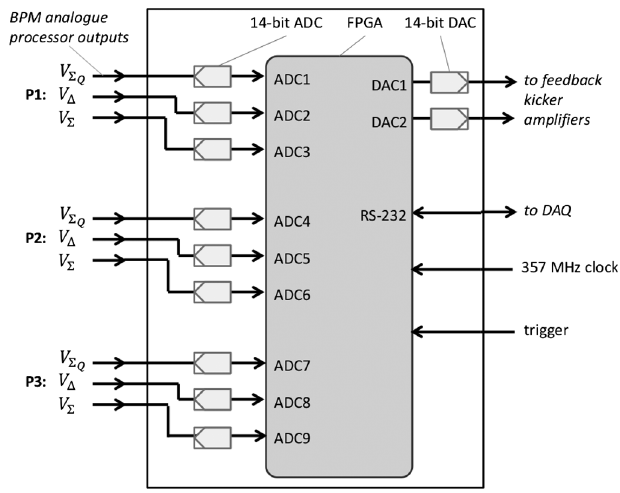
FIG. 14. Schematic of the FONT5 digital feedback